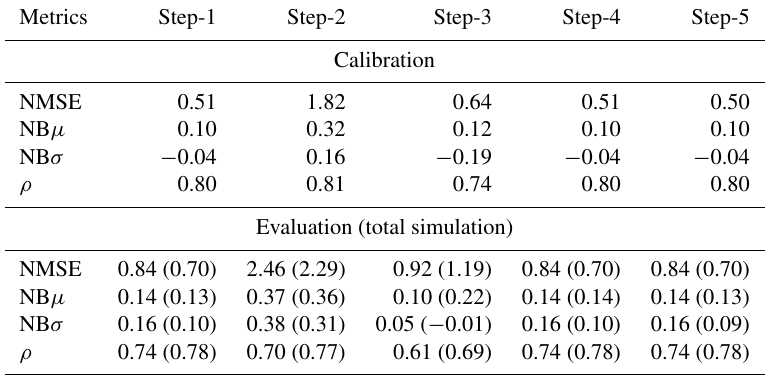
Table 8. Streamflow error statistics for calibration, evaluation, and total simulation (in parentheses) for all five different steps in Stage-II